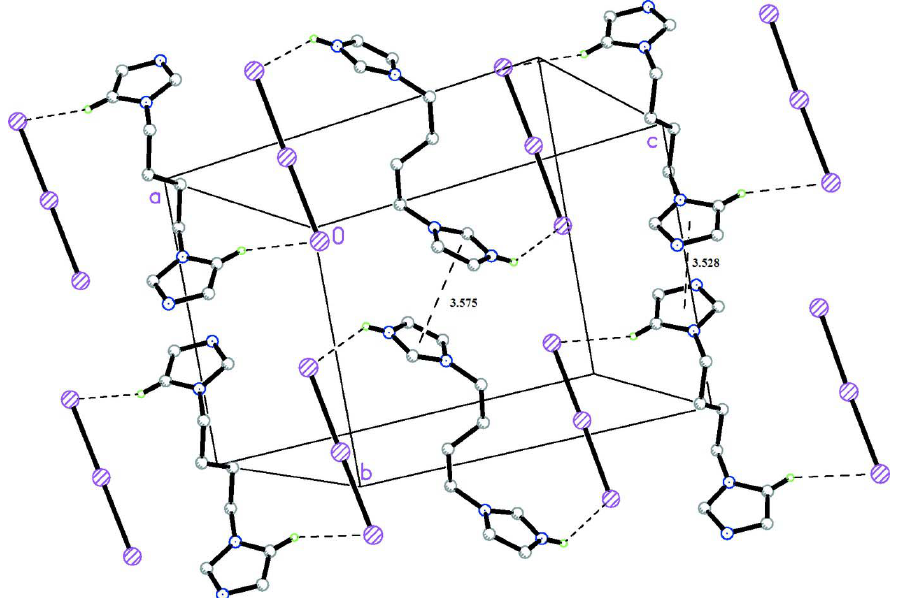
Figure 2 A partial packing view, showing π - π interactions. Dashed lines indicate the hydrogen-bonding interactions and π - π interactions. H atoms not involved in hydrogen bonds have been omitted for